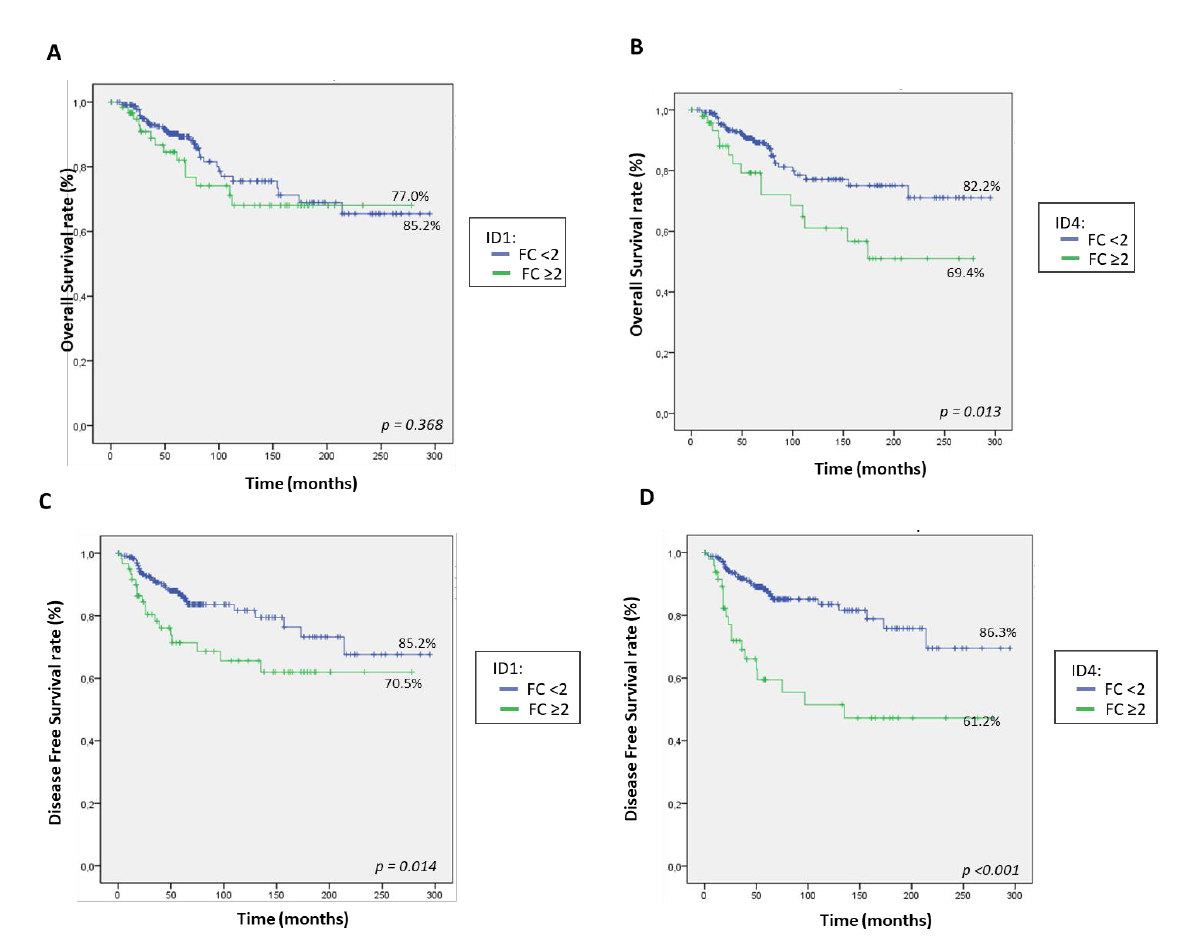
Figure 4. Kaplan–Meier plot for overall survival ( A , B ) and disease-free survival ( C , D ) rates (%) for all patients classified according to tumor ID1 ( A , C ) or ID4 ( B , D ) mRNA expression.